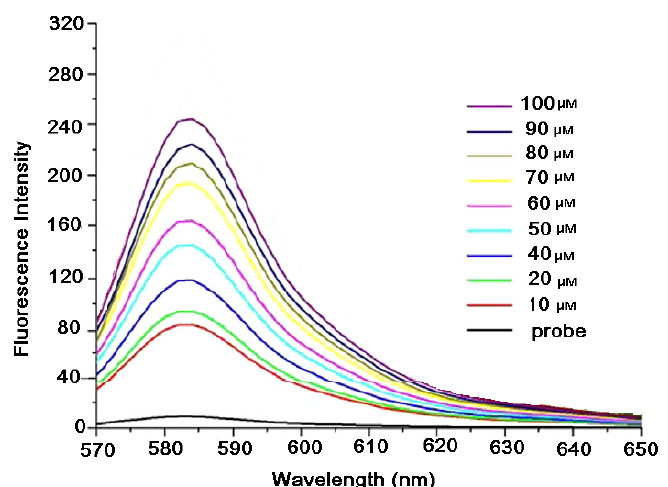
Figure 4. Concentration-dependent fluorescence response for VRF probe (10 µM) upon addition of Hg 2+ (10 – 100 µM) in CH 3 CN:HEPES buffer (1:1, 0.1 M, pH = 7.4).at 25 °C; excitation wavelength = 560 nm, emission wavelength = 585 nm.